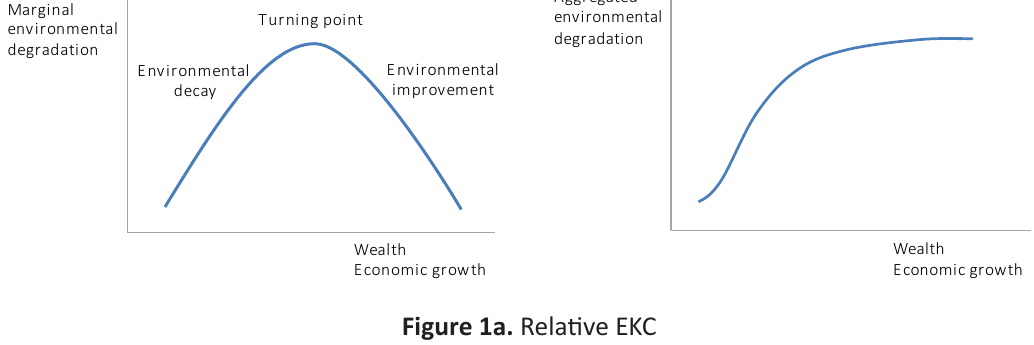
Figure 1a. Relative EKC